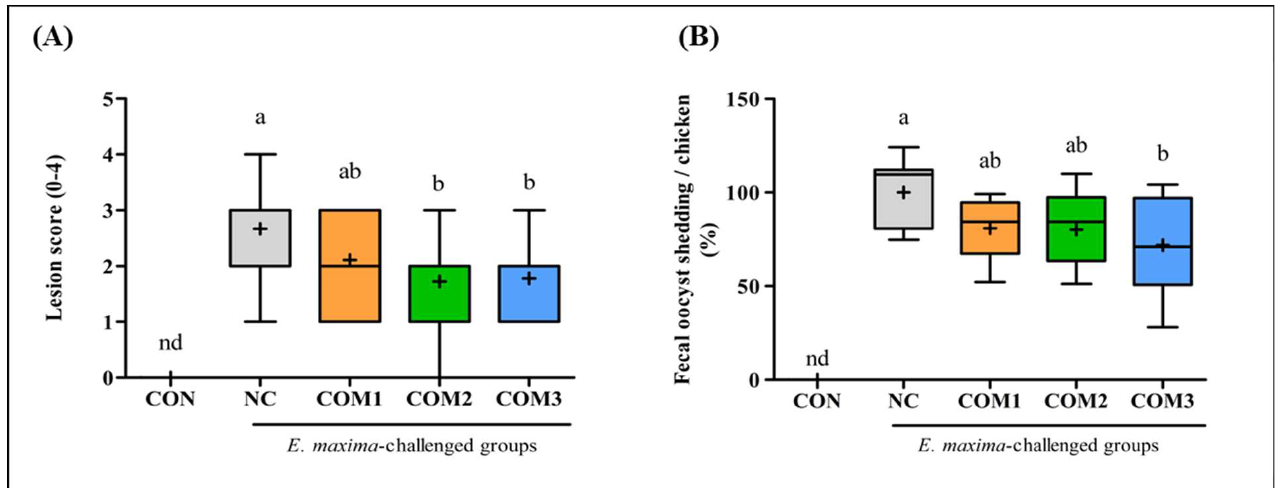
Figure 3. Synergetic effect of recombinant EF-1α and B. subtilis expressing cNK-2 peptide on the jejunal lesion score ( A ), and fecal oocyst shedding ( B ) post- E. maxima infection. a–b different letters between group denote significant differences ( p < 0.05) according to the Tukey’s multiple range test ( n = 30). Abbreviations: CON, non-immunized and non-infected control; NC, non-immunized and infected control; COM, component; nd, not detected.